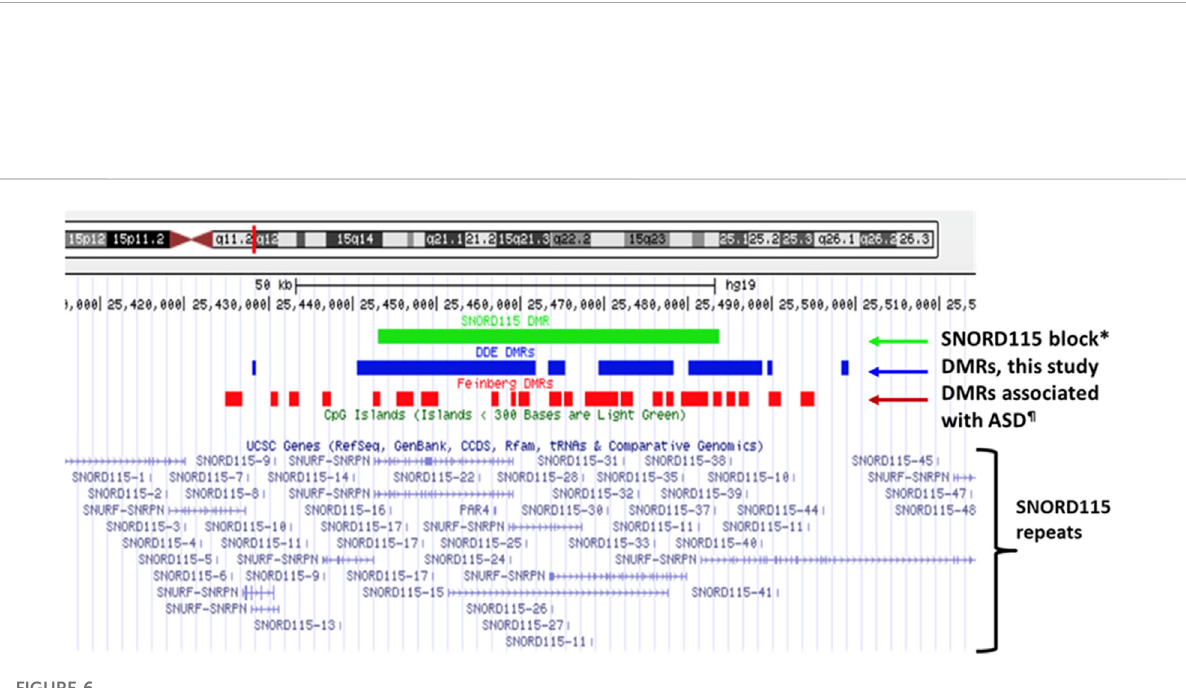
FIGURE 6 SNORD115 block (*) on chromosome 15 showing signi fi cant genome-wide differential methylation between exposure groups after correction formultipletesting.Thegreenbaridenti fi esthelocationoftheSNORD115blocklocatedonchromosome15,whiletheblueandredbarsindicatethe locations of theDMRs identi fi ed inthis study and theprior study on sperm from fathers of children with ASD byFeinberg etal. (2015). The location of distinct SNORD115 repeats are also